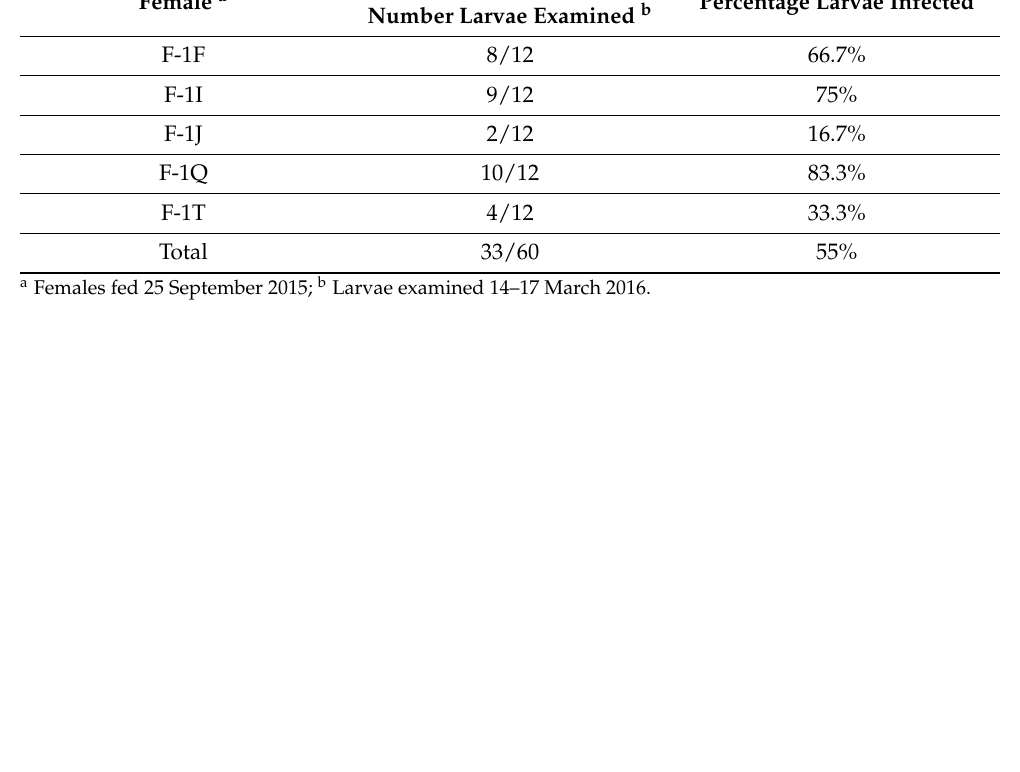
Figure 4. Borrelia hermsii in an O. hermsi egg stained with anti- B. hermsii rabbit hyperimmune serum and goat anti-rabbit FITC ( A ) and stained again with the anti-Vtp mouse monoclonal antibody and goat anti-mouse RITC ( B ). Scale bar = 40 µm.